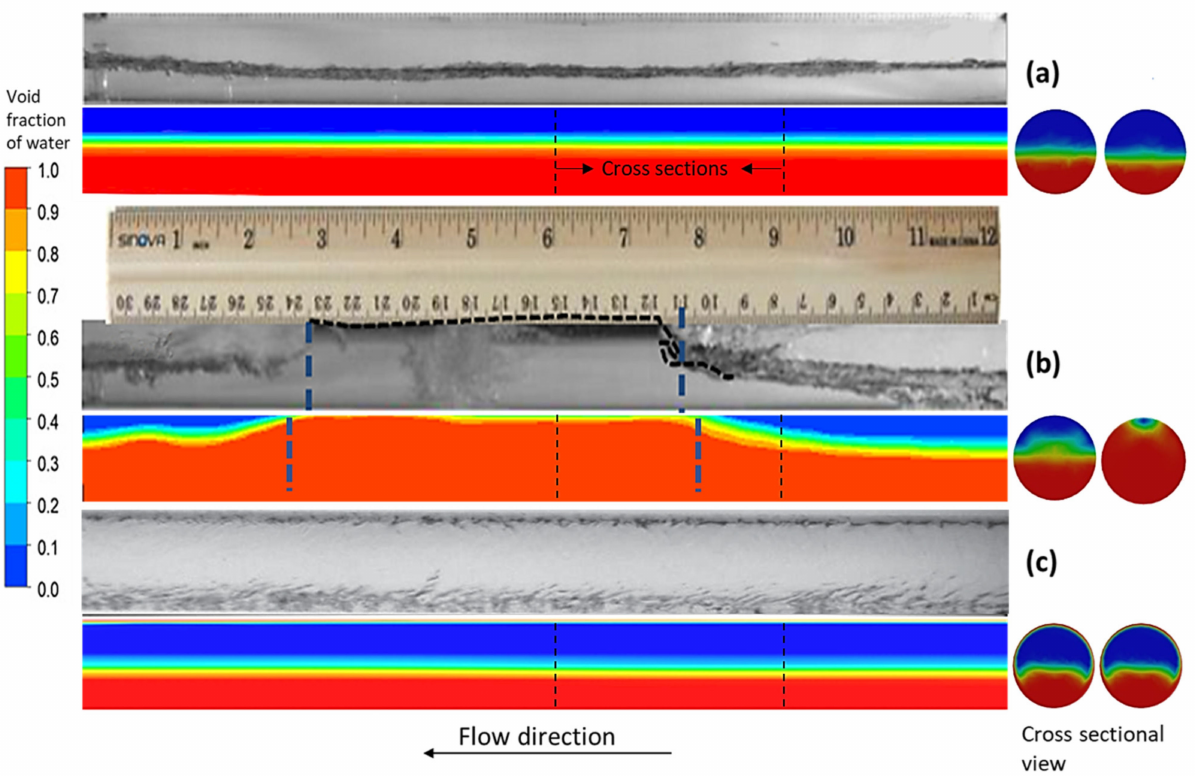
Figure 6. Comparison of flow morphology of simulation results against experimental results from the literature for ( a ) stratified ( U SL = 0.02 m/s, U SG = 0.1 m/s) [38], ( b ) slug ( U SL = 1 m/s, U SG = 2.44 m/s) [38], and ( c ) annular flow ( U SL = 0.5 m/s, U SG = 20 m/s) [39]